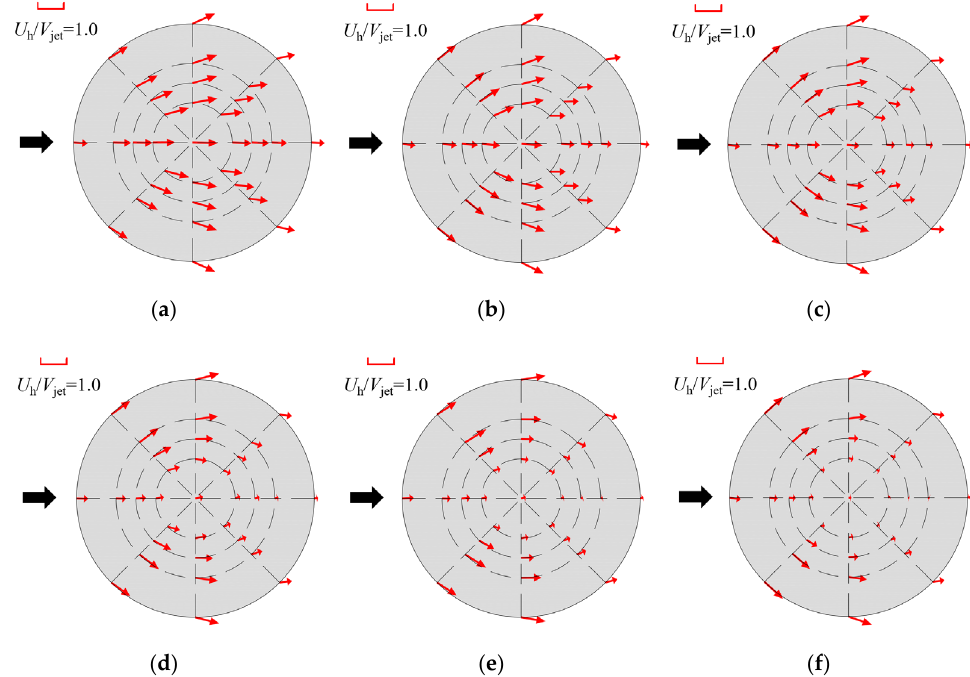
Figure 11. Vectors of the maximum horizontal wind velocities ( L = 0.5 D jet , r h = 1.0 D jet ): ( a ) H / h = 1/12; ( b ) H / h = 1/6; ( c ) H / h = 1/4; ( d ) H / h = 1/3; ( e ) H / h = 5/12; ( f ) H / h = 1/2.